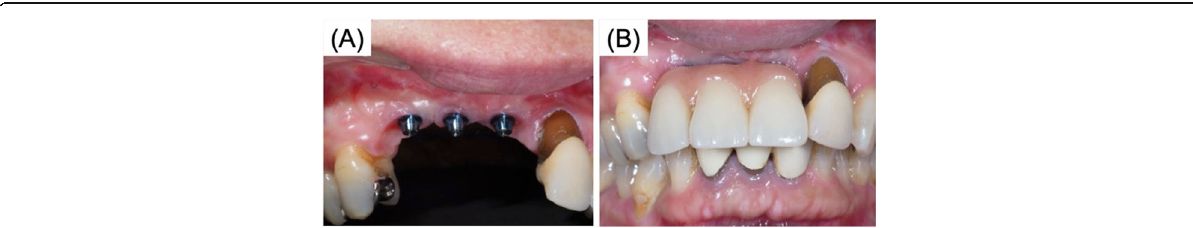
Fig. 7 After gingivoplasty with palate graft for prevention of peri-implantitis. a Intraoral findings after gingivoplasty. b Intraoral findings, final